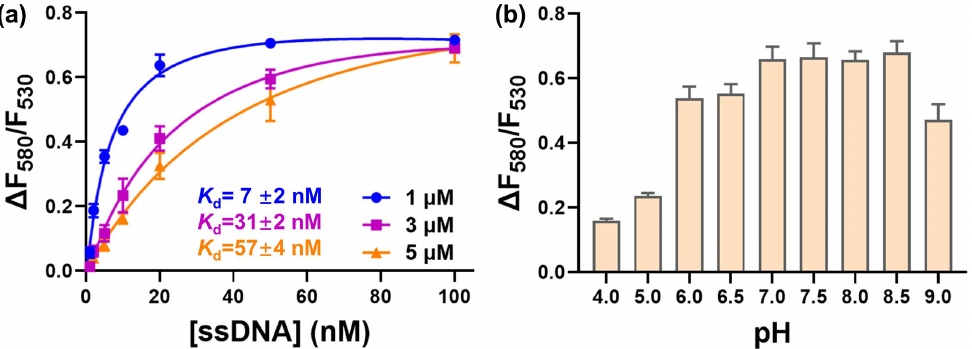
Figure 3. ( a ) The fluorescence ratio changes of PMNT in response to ssDNA concentration with PMNT ranging from 1 to 5 μM. ( b ) The fluorescence ratio changes of PMNT in response to different pH values. The concentration of ssDNA was 100 nM, and the concentration of PMNT was 5 μM.